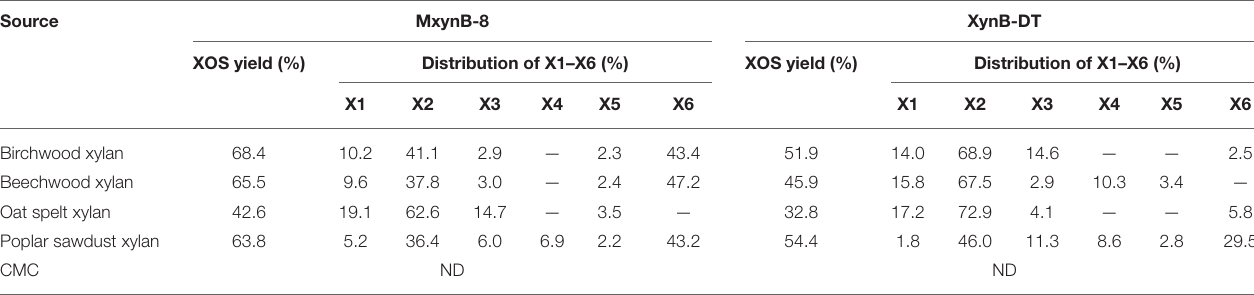
Birchwood xylan Beechwood xylan Oat spelt